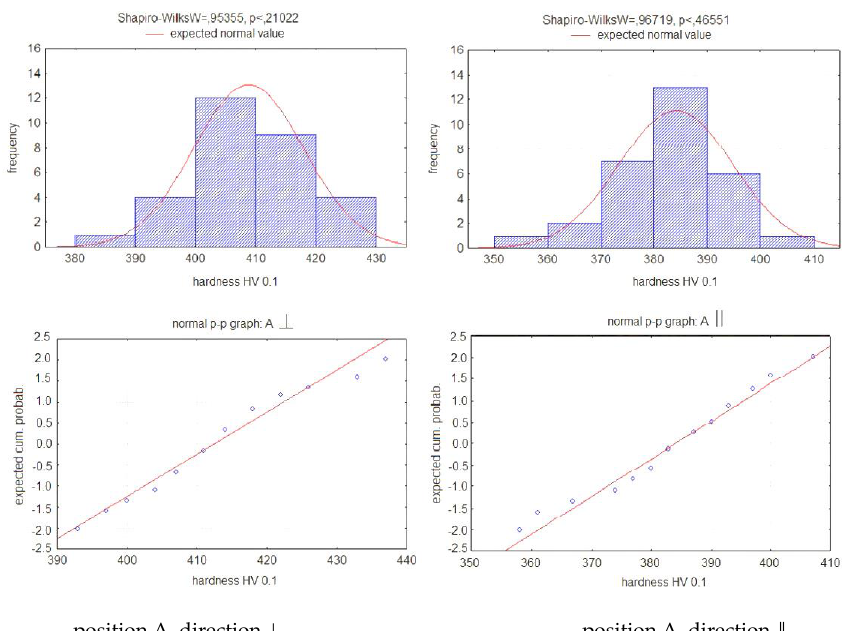
Figure 5. Histogram and normal p – p graph for position A and both directions.